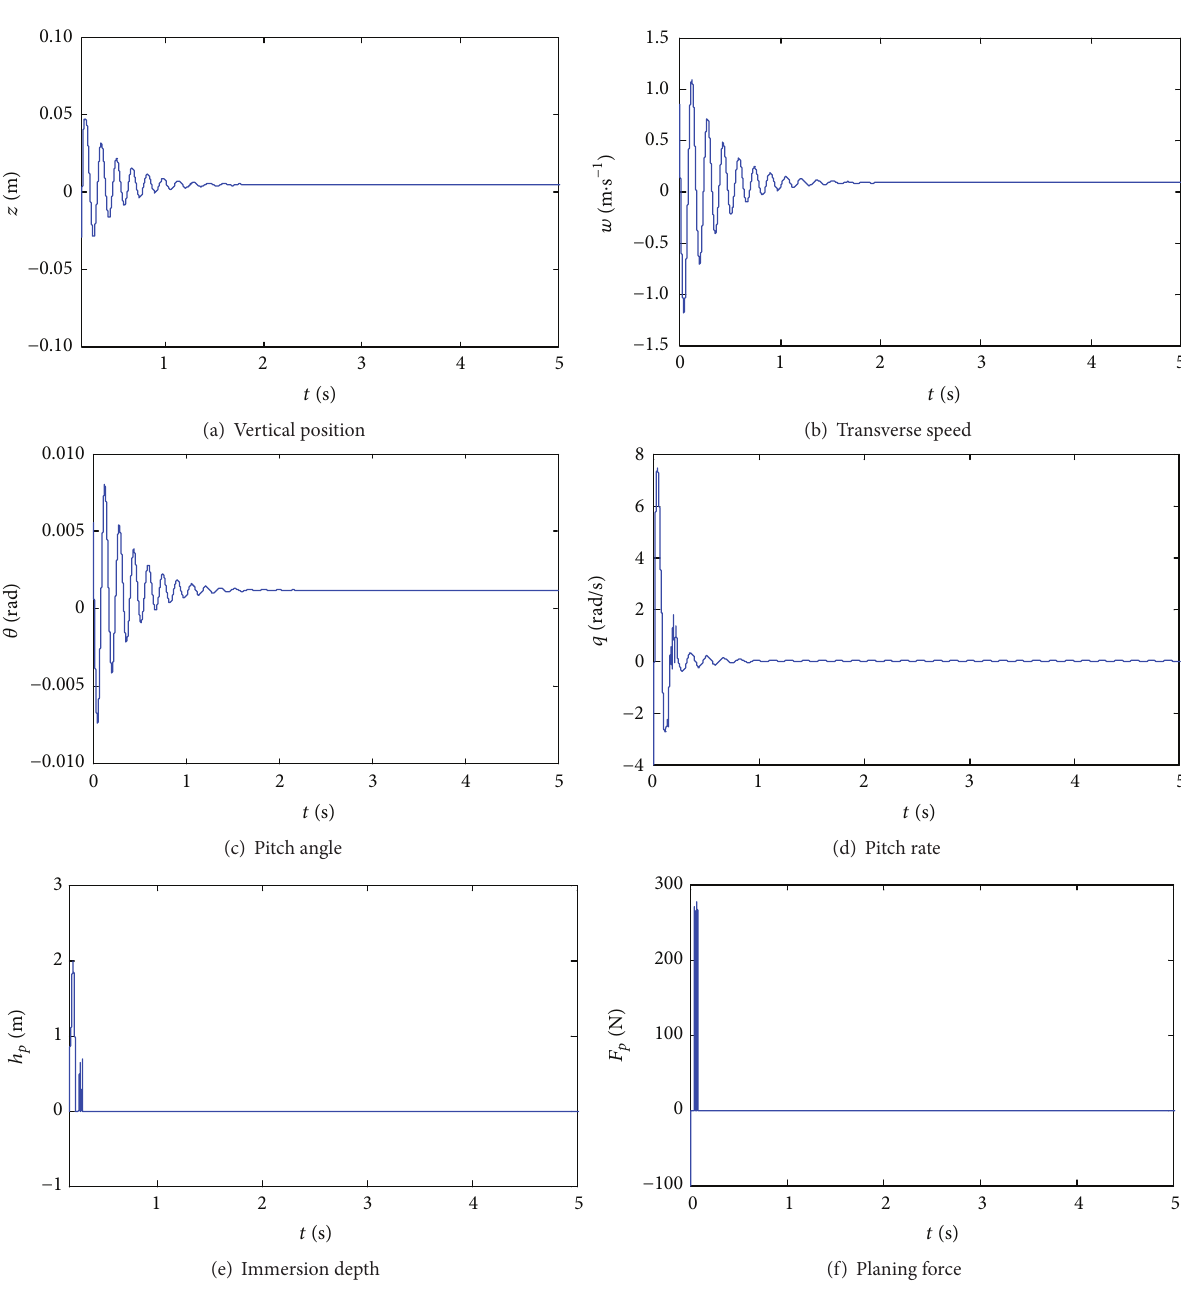
Figure 8: The motion state of the system when 𝑘 = −21.95